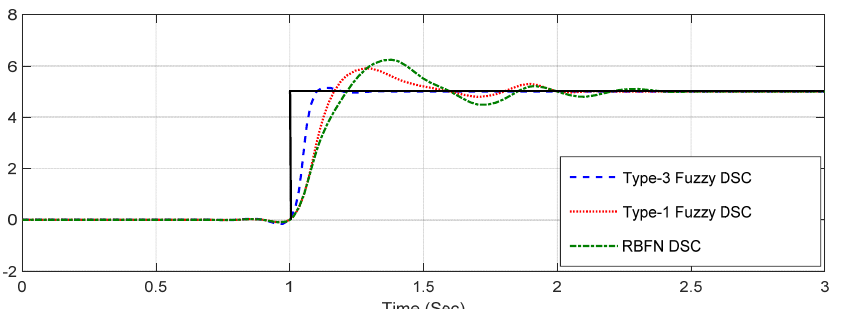
Figure 6. Comparison of dynamic surface control performance based on the type-3 fuzzy system, type-1 fuzzy system, and RBFN.